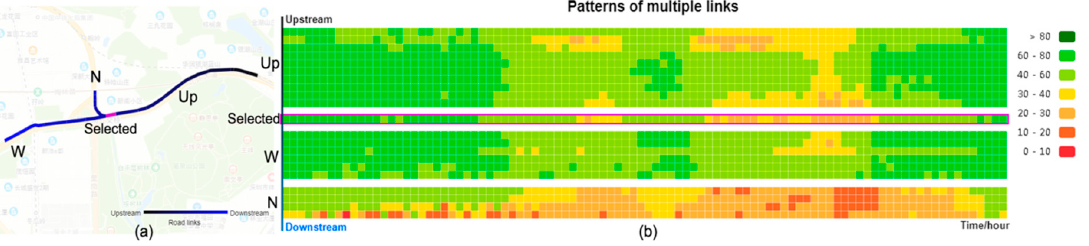
Figure 5. Traffic patterns of adjacent road links. ( a ) The topology of local road links. ( b ) The traffic dynamics.